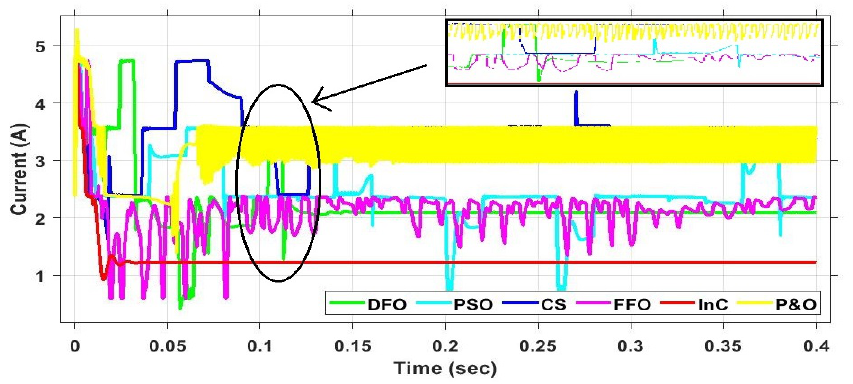
Figure 14. PS1 current comparison between all algorithms for centralized PV system.